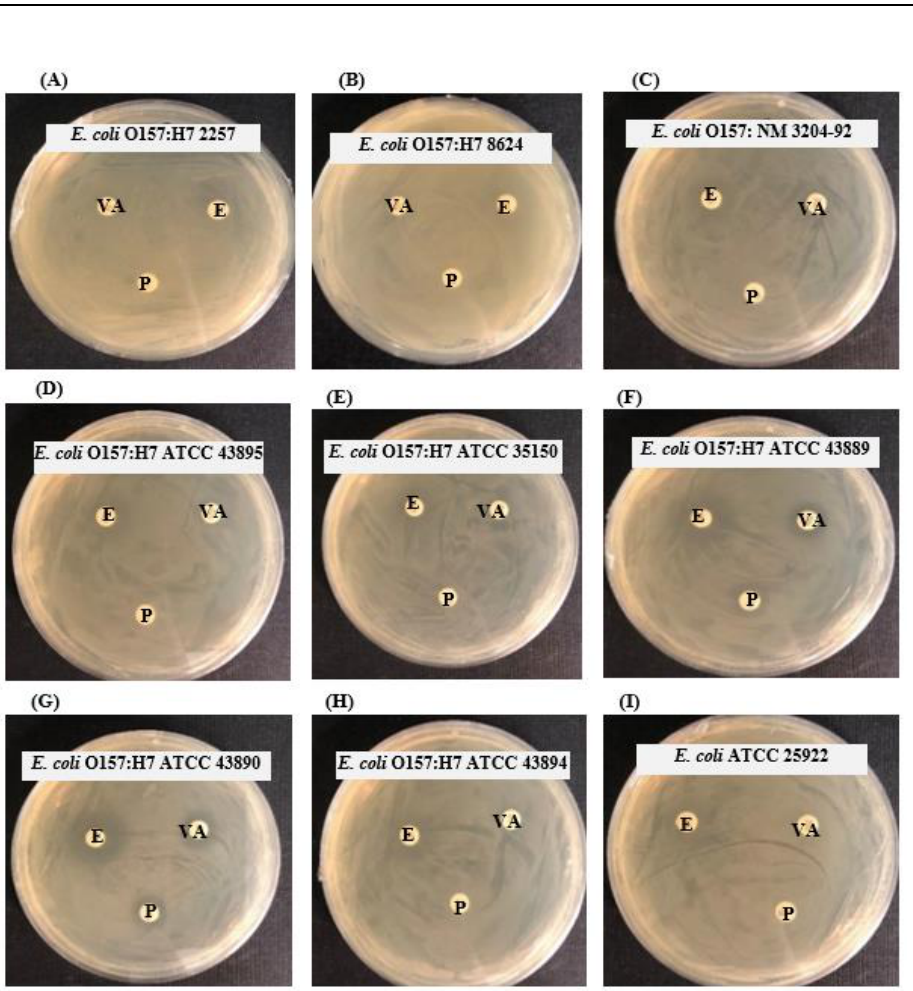
Figure 7. Antibacterial activity of some commercial antibiotics against nine E. coli O157:H7 strains